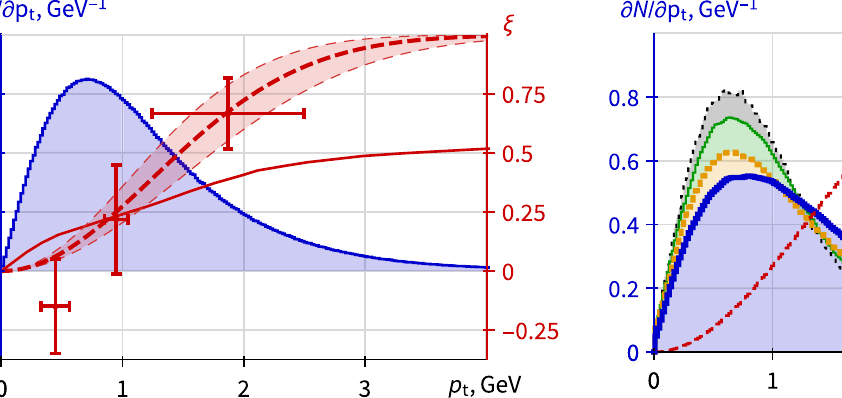
Fig. 1 Λ c initial polarisation as a function of transverse momentum (red curves) on top of its distribution over transverse momentum (his- tograms). Red solid curve – theoretical prediction [51], red crosses – experimental data [52], red dashed curve – experimental data fit by Eq. (23); blue histogram (left plot) – distribution over transverse